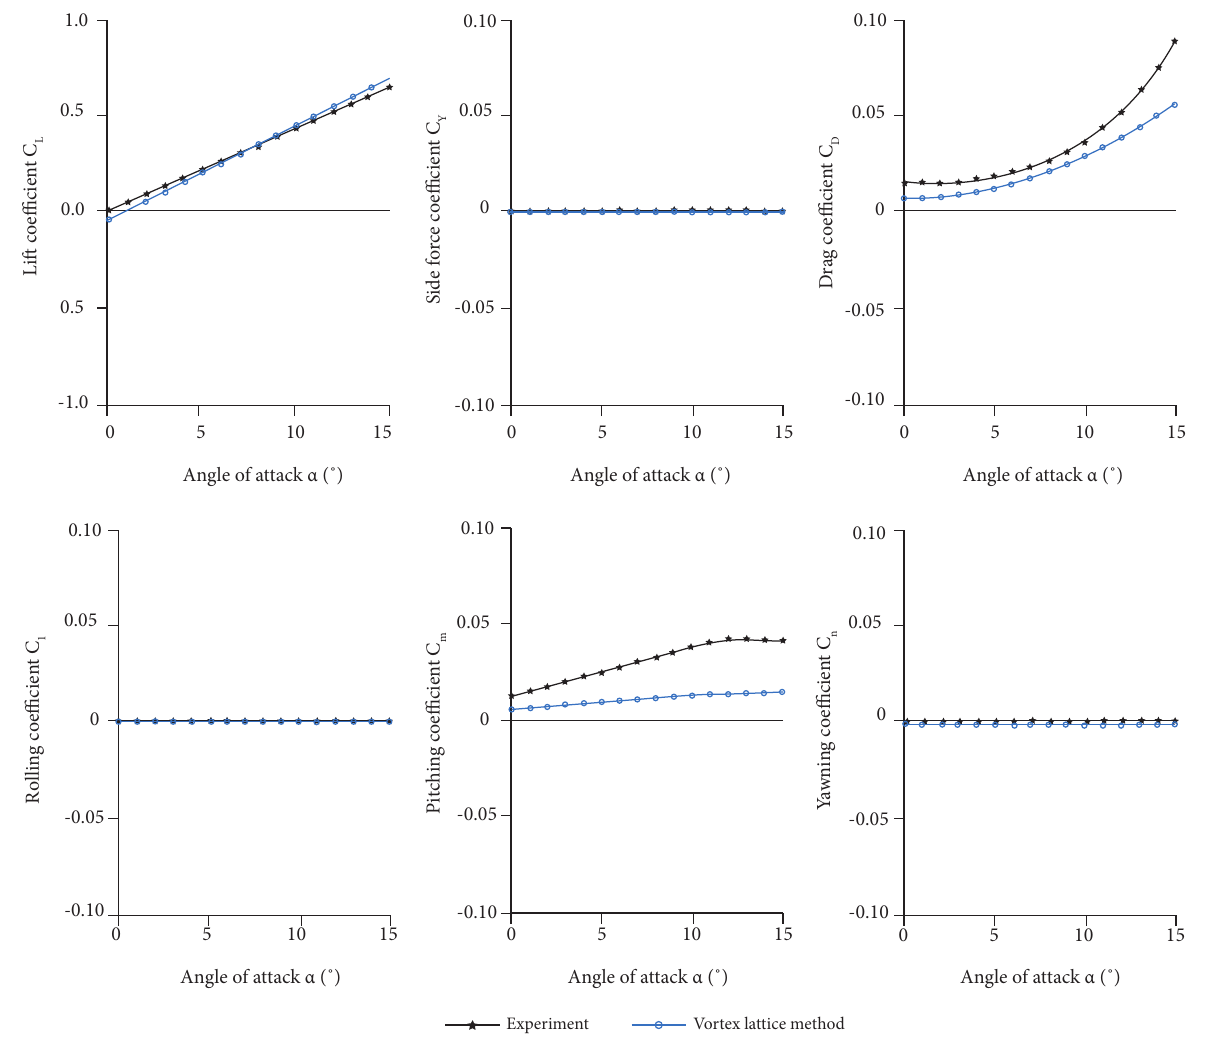
Figure 3. Comparison of coefficients of the reference